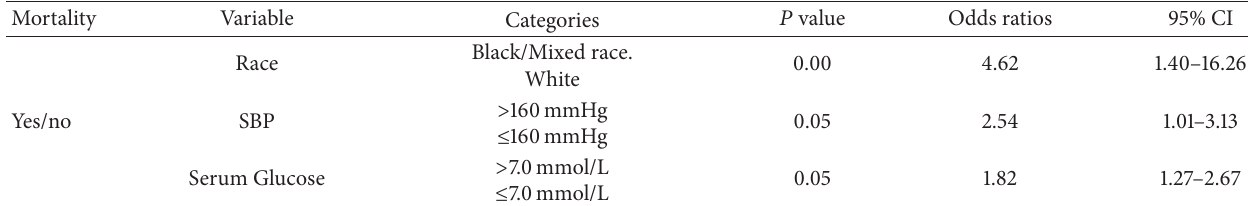
Table 3: Risk factors related to mortality revealed by the binary logistic regression analysis. Mortality Variable